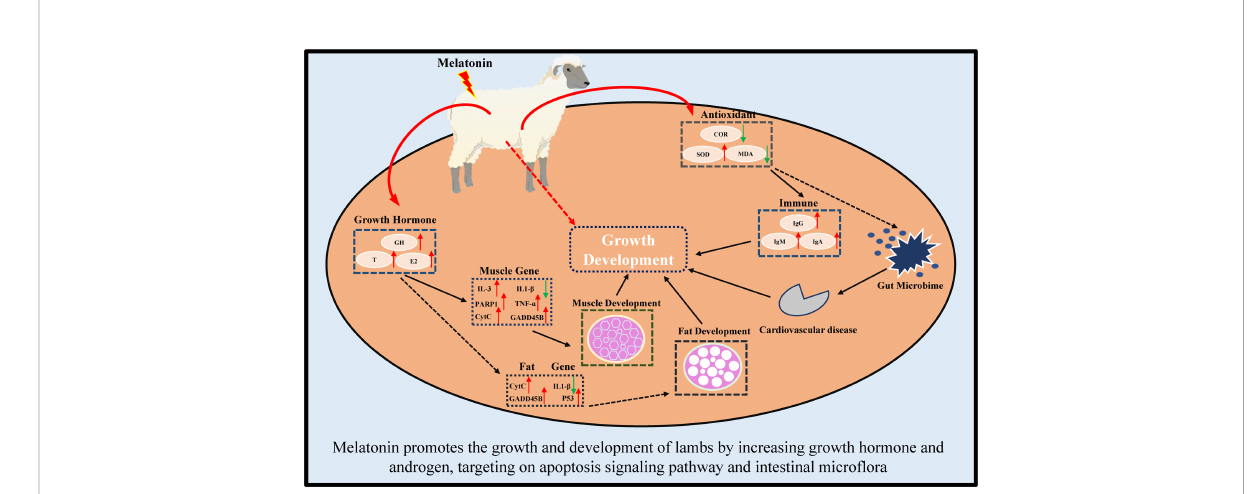
FIGURE 12 Schematic diagram of melatonin promoting growth and development of